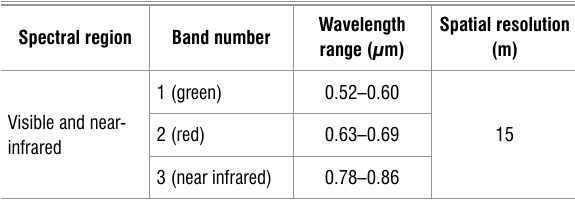
Table 1: Wavelength ranges, and spatial and radiometric resolutions of Advanced Spaceborne Thermal Emission and Reflection